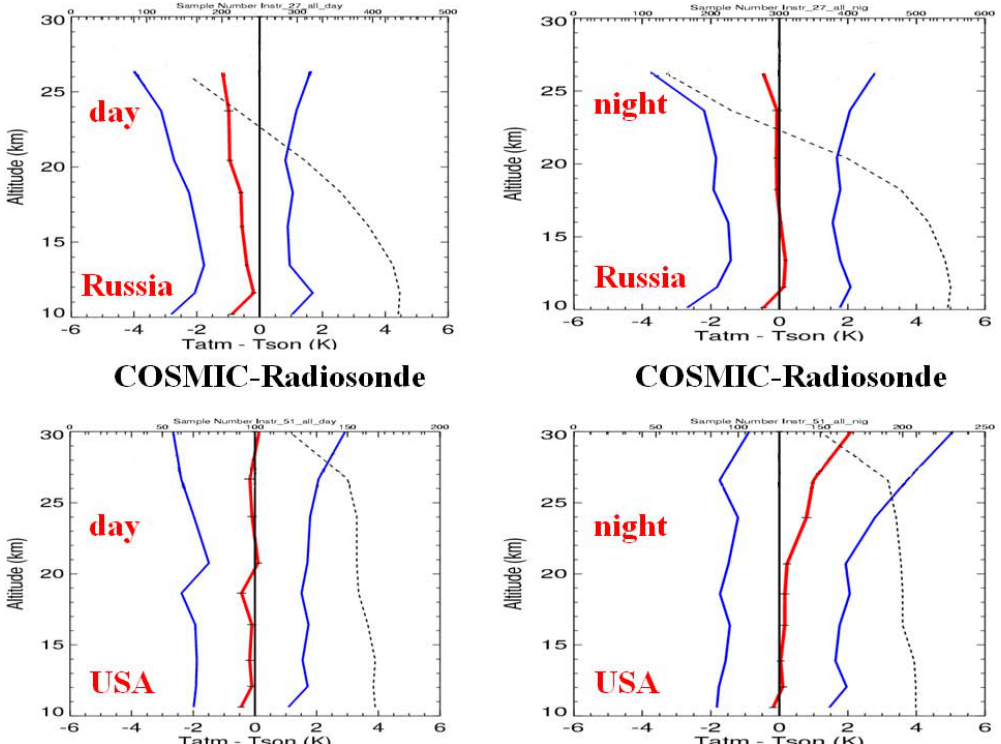
Fig. 4. Comparison of two different types of radiosonde (Russian and US) with COSMIC RO observations during the day and night. The red curves are the mean differences. The two blue curves are the standard deviation of the differences. The dashed black line is the number of pairs at each level. The RO soundings, which are not affected by sunlight, reveal biases in the Russian radiosondes during the day and the US radiosondes during the night (He et al., 2009).